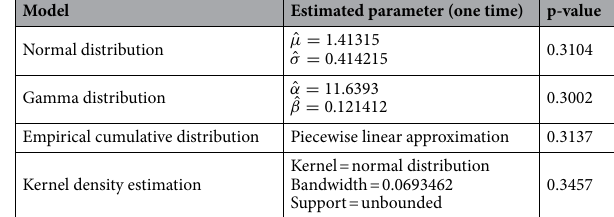
Model Estimated parameter (one time) p-value